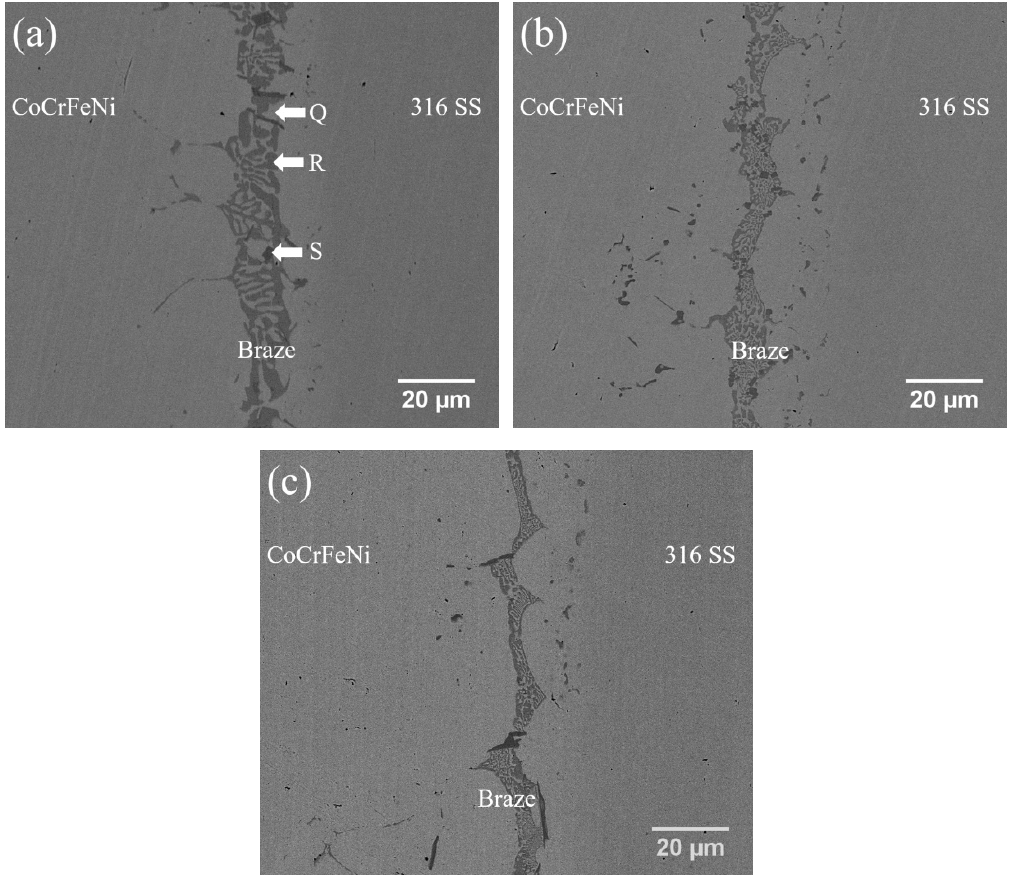
Figure 7. The BEIs of CoCrFeNi/MBF601/316 joints infrared brazed at ( a ) 1050 °C for 180 s, ( b ) 600 s and ( c ) 1080 °C for 600 s.